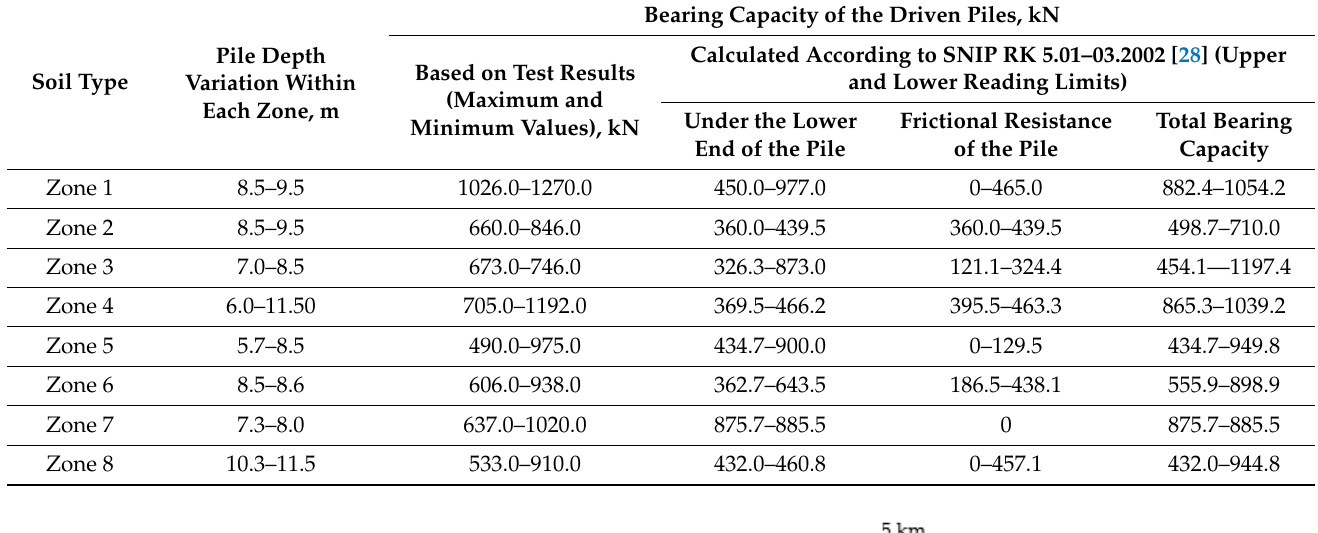
Table 4. Bearing capacity of the driven piles according to the performed tests.